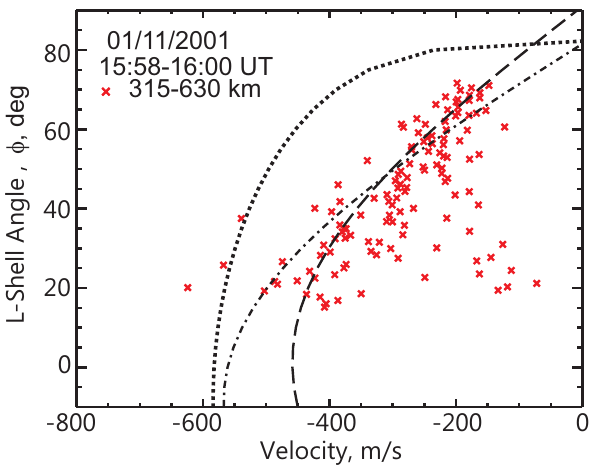
Fig. 11. Scatter plot of the E-region velocity (red crosses) versus L-shell angle for the Stokkseyri scan 15:58:00–15:59:48UT (the same as in Fig. 8b), cosine fit line for these data (dashed line), and expected velocity variations with L-shell angle according to Bah- civan et al. (2005) (dash-dotted line) and empirical dependence by Nielsen et al. (2002) for VHF (dotted